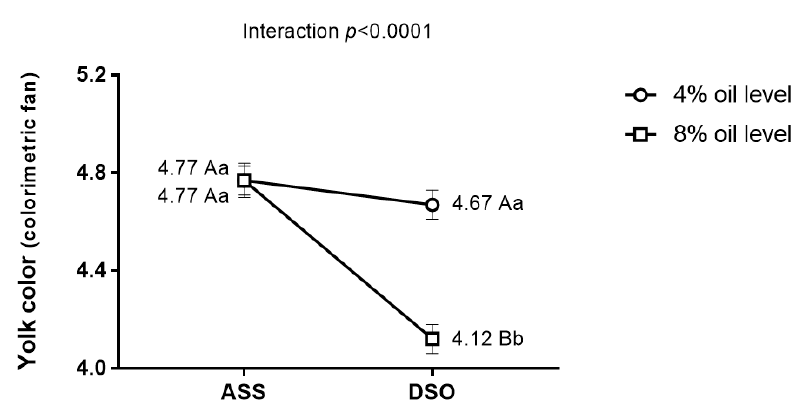
Figure 5. Effect of interaction between type of oil and level oil on yolk color of the eggs of Japanese quails. Different lowercase letters are significantly different between type of oil; Different capital letters are significantly different between level